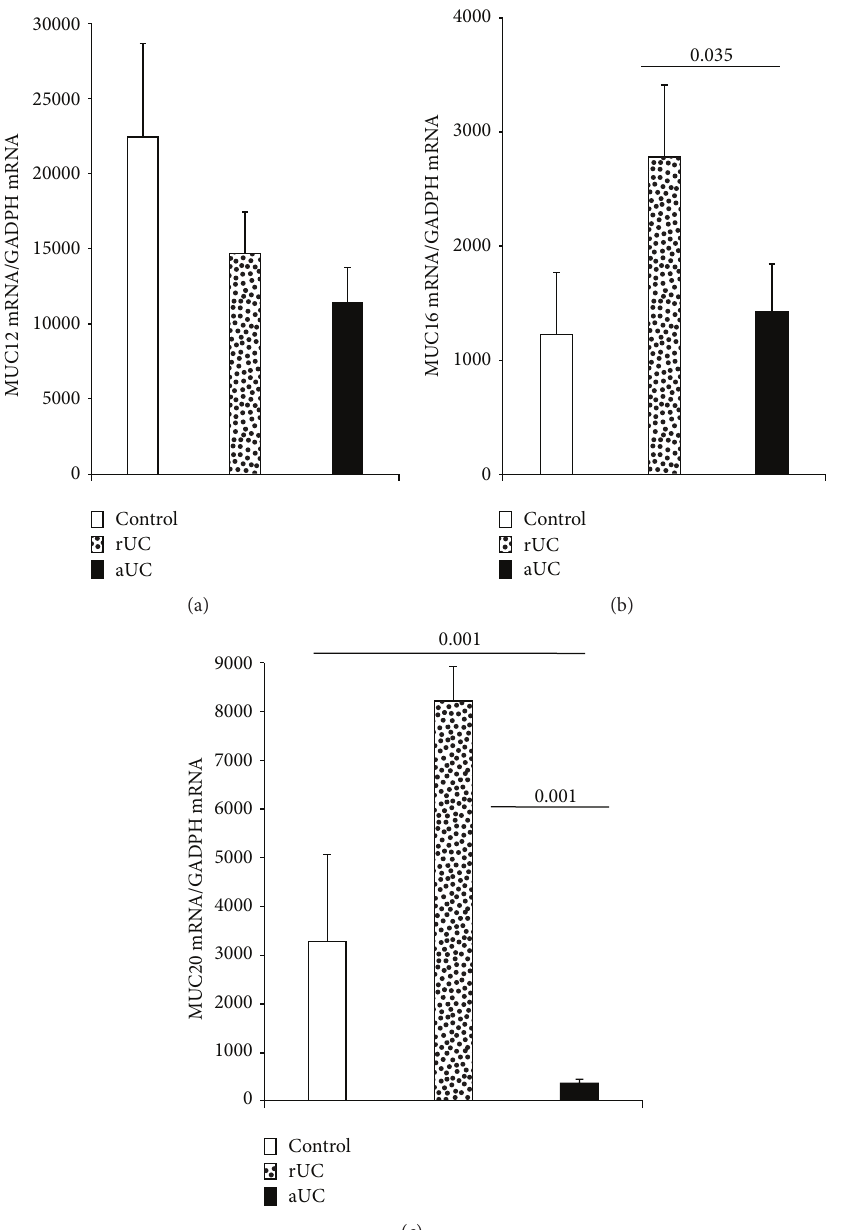
Figure 1: (a) MUC12, (b) MUC16, and (c) MUC20 mRNA levels in rectal mucosa from patients with ulcerative colitis ( 𝑁 = 40 ) and controls ( 𝑁 = 30 ). RT-qPCR was performed to assess mRNA levels in colonic mucosa biopsies from UC patients; bars show means with standard error of the mean of MUC20 transcript levels with GAPDH as housekeeping gene determined by 2ΔΔ Ct.